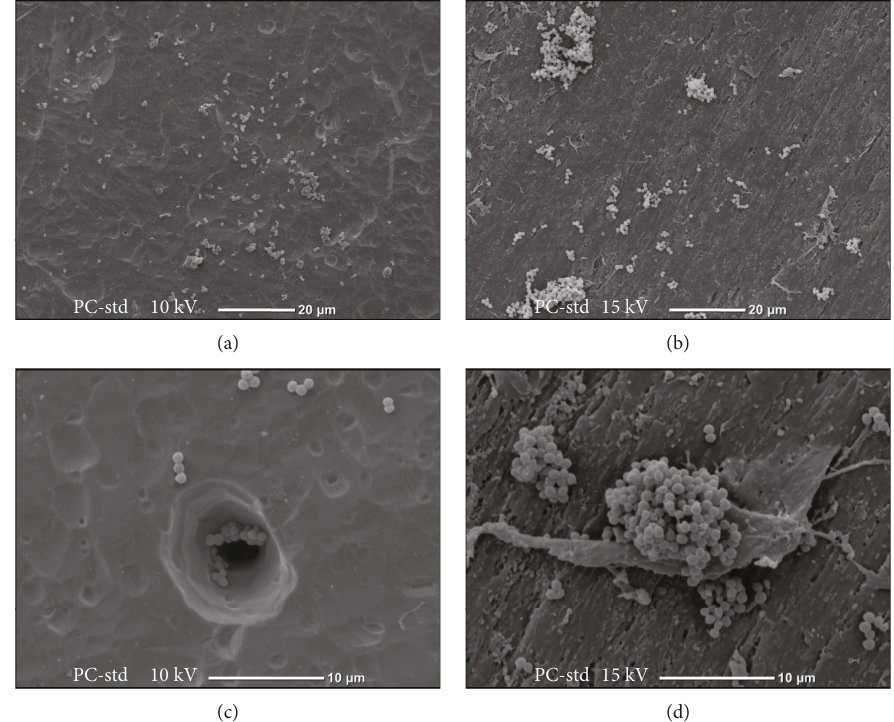
Figure 4: The SEM images of the surface of Ti (a, c) and HA-PLLA (b, d) at 24 hours of incubation after vortex washing. The images show that some few bacteria remained on the surface of both materials even after thorough washing and were capable of growing with